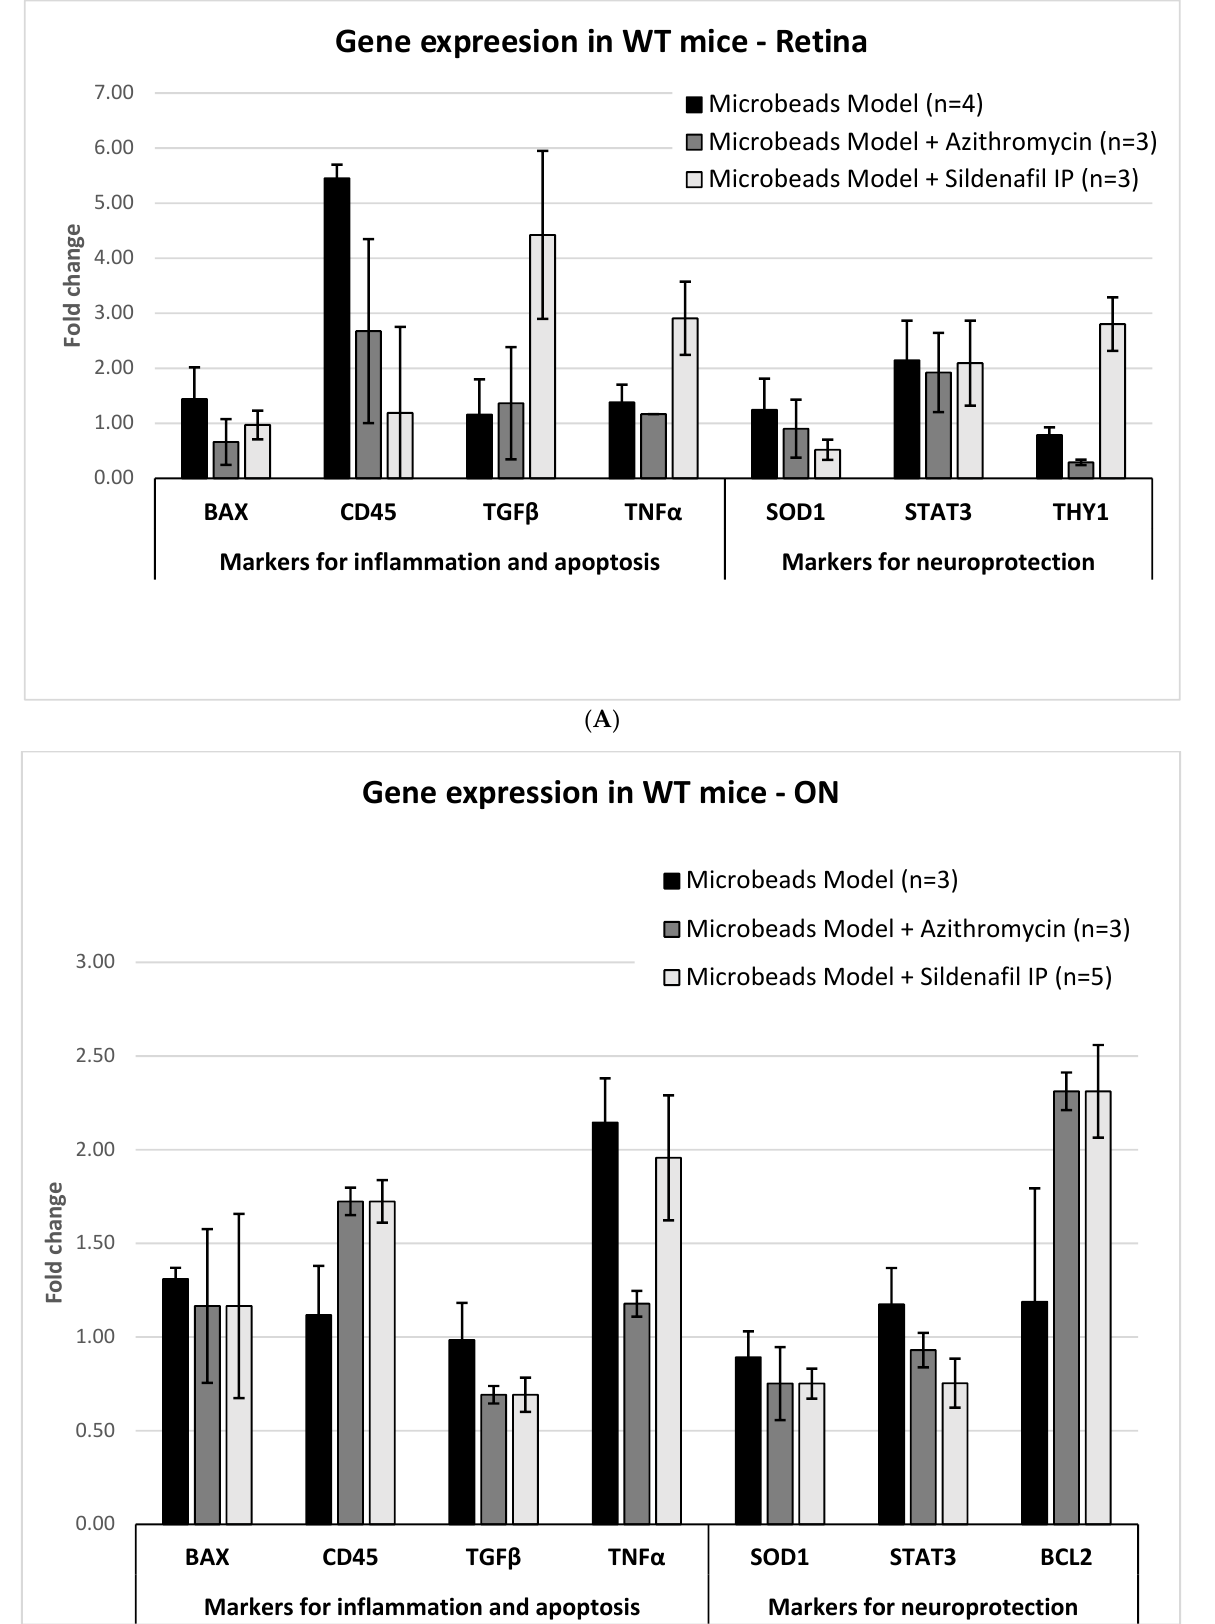
6 of 21 Figure 3. H&E staining showing the retinal thickness in WT mice . ( A ) microbead-injected eyes showing a retinal thickness of 184.22 µm. ( B ) control eyes showing a retinal thickness of 193.74 µm. H&E, hematoxylin and eosin; WT, wild type. 2.3. Molecular Analysis Molecular analysis was performed following euthanasia in WT and TLR4KO mice on day 3 after induction of the model. 2.3.1. Glaucoma Microbead Model: WT Mice